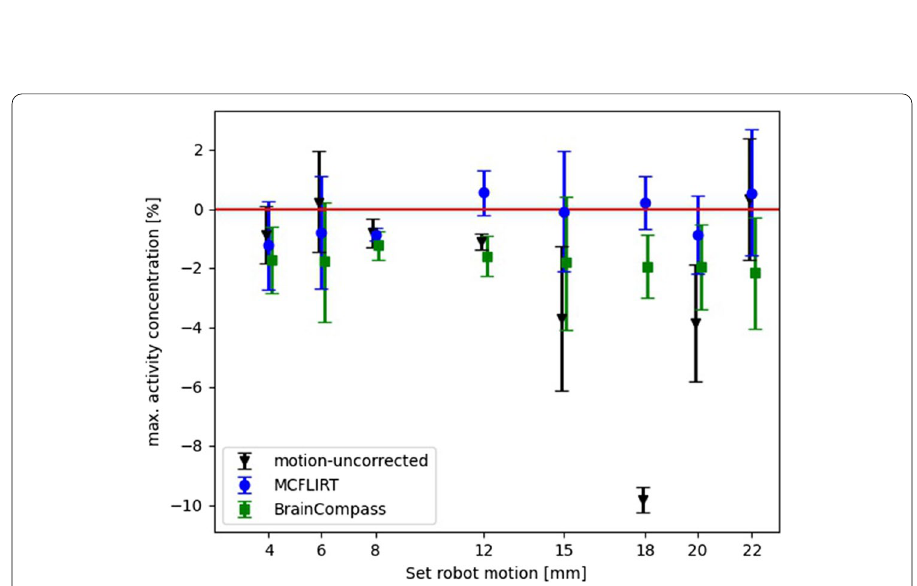
Fig. 9 Representation of the relative deviation of A max without any MoCo and after application of BrainCompass and MCFLIRT. The red line symbolizes A max for the reference (before